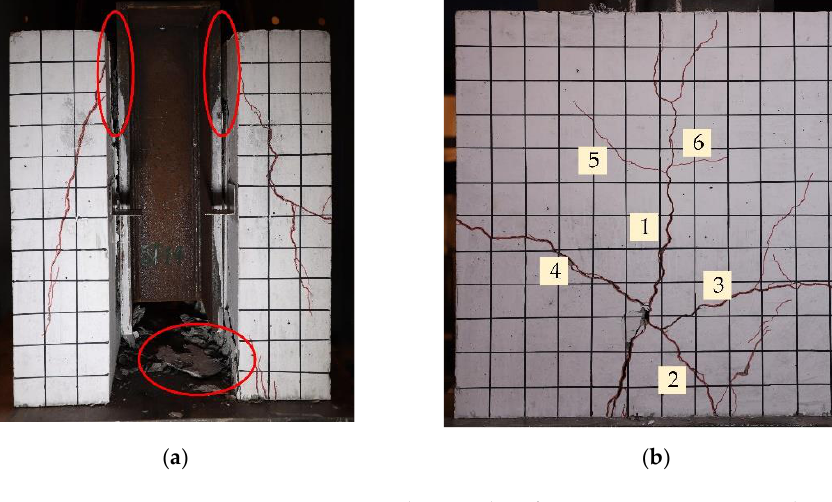
Figure 7. Failure modes of composite connectors with end-bearing concrete: ( a ) front of concrete slab; ( b ) side of concrete slab; ( c ) perforated steel plate.